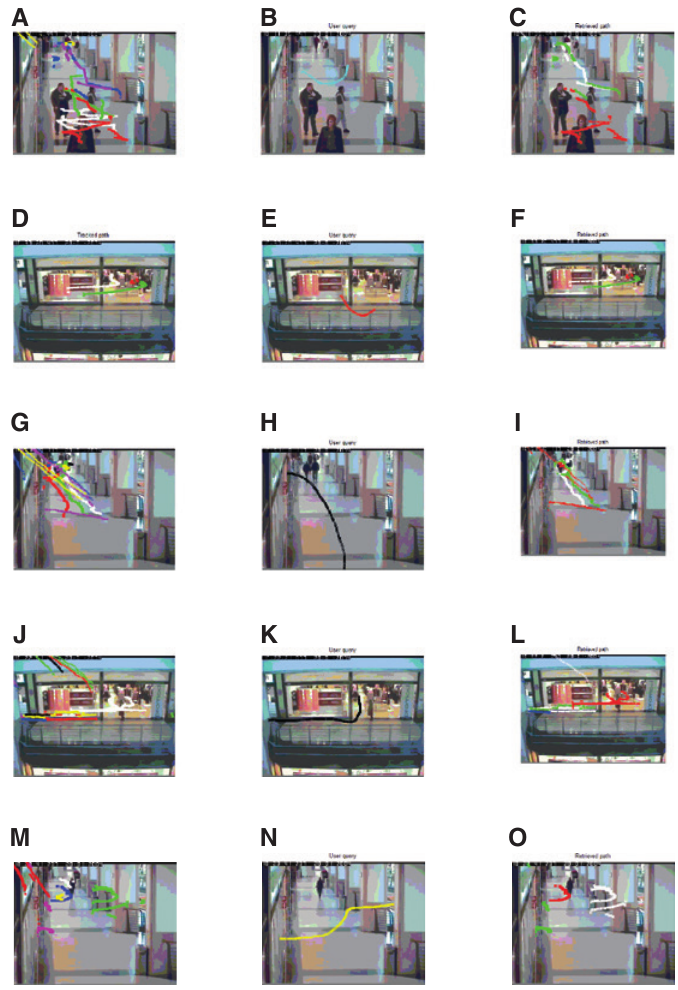
Figure 4: Tracking Results Using the Hybrid